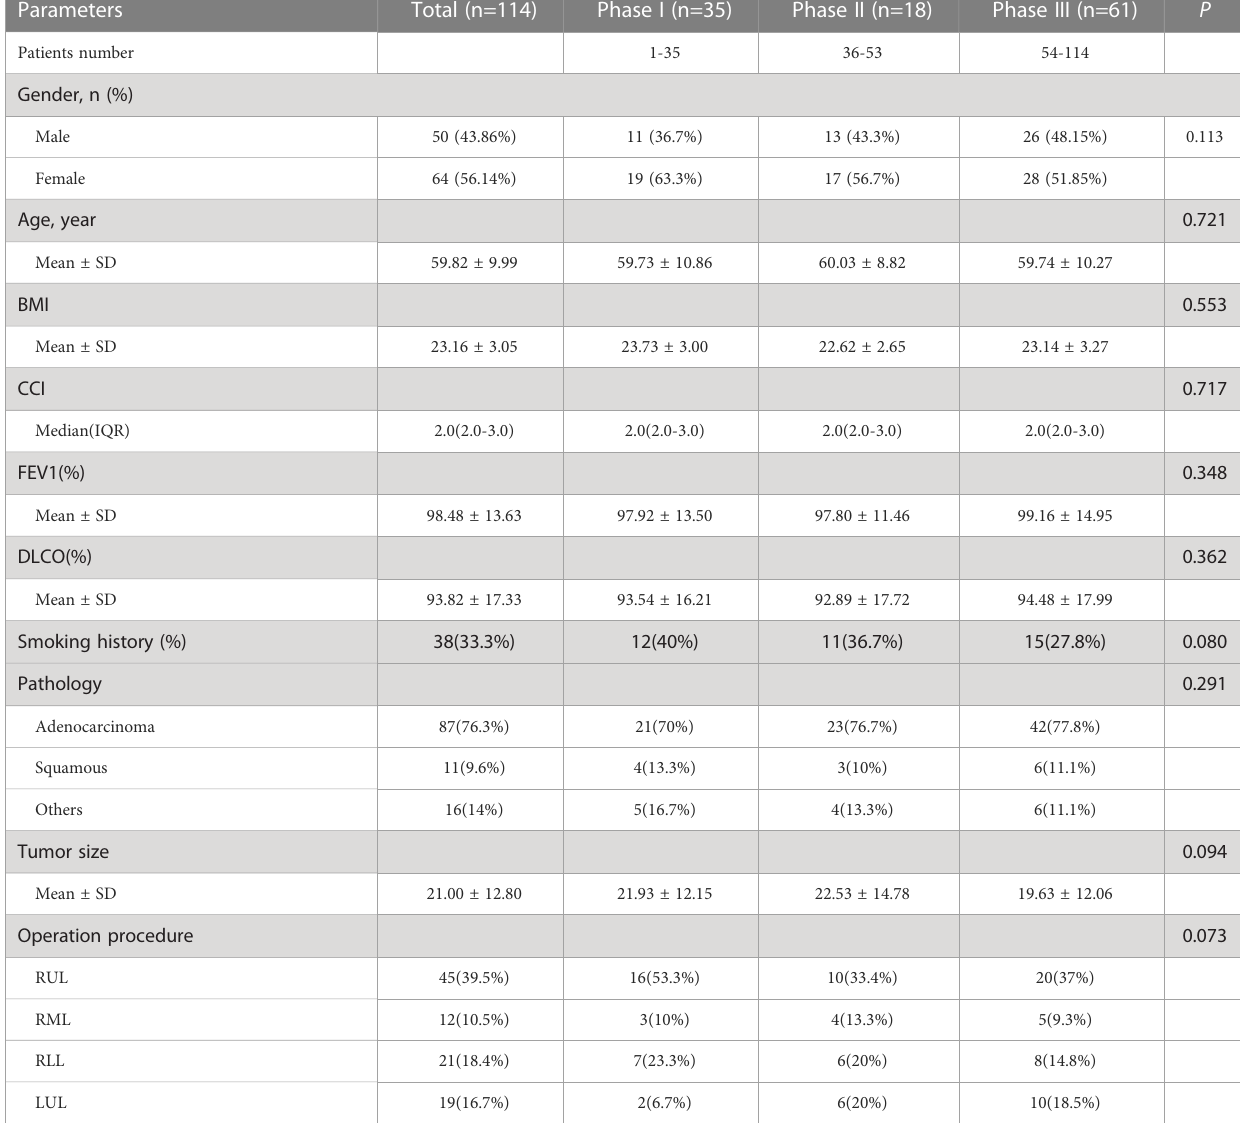
TABLE 1 Patients ’ demographics and surgical outcomes according to learning curve